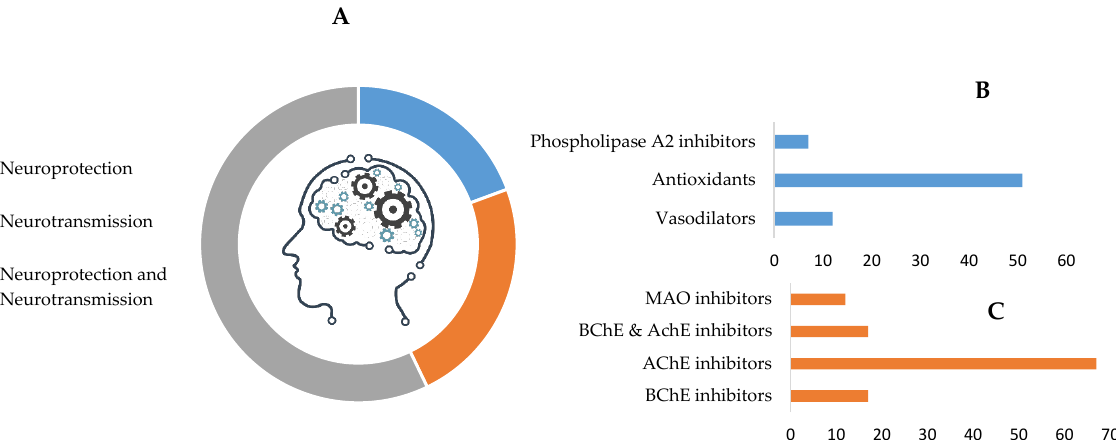
Figure 2. Summary of the main mechanisms by which botanicals may enhance cognition ( A ). Main relative contributions to neuroprotection ( B ) and neurotransmission ( C ) are highlighted. AChE—acetylcholinesterase; BChE—butyrylcholinesterase; MAO—monoamine